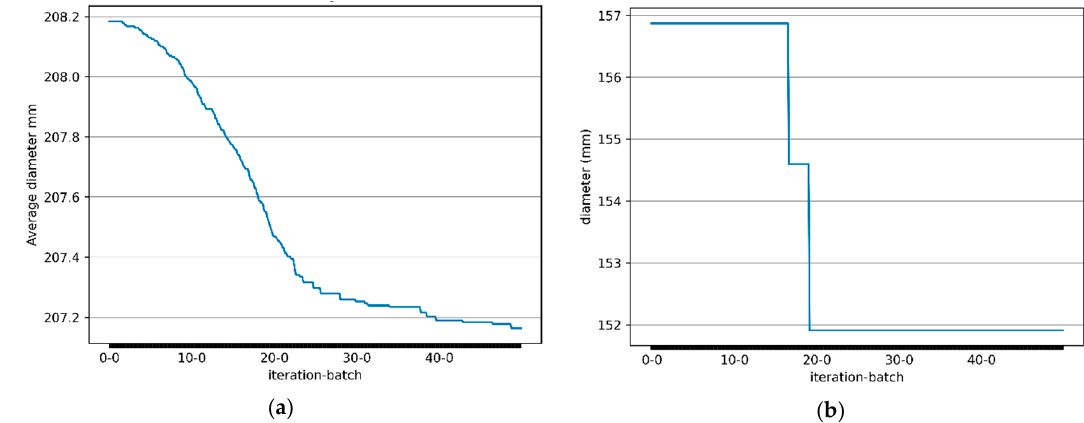
Figure 5. ( a ) Evolution of the average diameter for a particular type of roll; ( b ) evolution of the diameter of a particular roll.